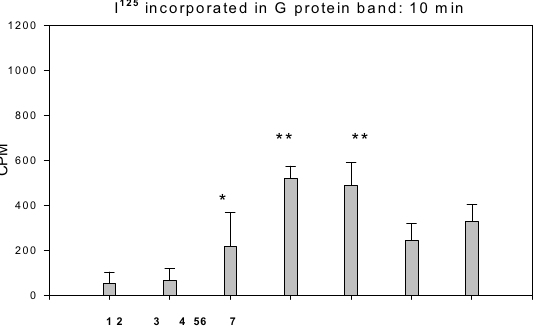
Figure 5 Covalent crosslinking of cyclase complex and quantification of G beta in the 'pull down' material . A: cross link- ing of cyclase complex Membranes were incubated with baclofen (200 nM) + isoproterenol (200 nM) in the presence of GTP (10 µ M) + EDTA (1 mM) with or without GTP γ S (10 µ M) plus Mg (5 mM). Membranes were then placed in ice with an excess of GDP (1 mM) and Mg (5 mM) (t = 0), then were solubilized at different times (1, 5 and 15 min). A 'pull down' of the cyclase(s) complex was carried out with Forskolin-agarose beads and the material bound to the affinity beads was cross-linked with link- ers (see 'materials and methods'). The molecular complexes were separated by gel electrophoresis and analyzed by Western blot using anti- beta antibody. left : bac + iso at 1, 5 min. Right : bac + iso + GTP γ S at 1, 5 and 15 min respectively. Arrows corre- spond to MW > 200, 80 and 35 kDa respectively. B: time course dissociation Gbeta /cyclase: quantification of Gbeta at 1 and 10 min Quantification of beta/gamma in cyclase(s) complex, 1 min and/or 10 min after a large excess of GDP was added. Membranes were incubated with isoproterenol (200 nM) and/or baclofen (200 nM) for 20 min at 20°C, according to the same protocol as in figure 4 then placed in ice. Large excesses of GDP (1 mM) and Mg (5 mM) were added. The membranes were solubilized after 1 min and/or 10 min and the cyclase(s) complex was isolated by Forskolin-agarose. To quantify the beta subunit bound to the affinity beads, we carried out a Bolton Hunter labeling of the affinity isolated material followed by gel elec- trophoresis. Instead of Western blot analysis, gels were dried and the band about MW = 35 kDa was excised and counted. The bars represent 3 determinations +/-SE. * and ** correspond to P < 0.1 and P < 0.05 respectively compared to iso and/or bac . Lane 1 : isoproterenol , lane 2 : baclofen, lane 3 : isoproterenol + baclofen , lane 4 : isoproterenol + baclofen + GTPyS, lane 5 : isoproterenol + baclofen + CTx , lane 6 : CTx , lane 7 :